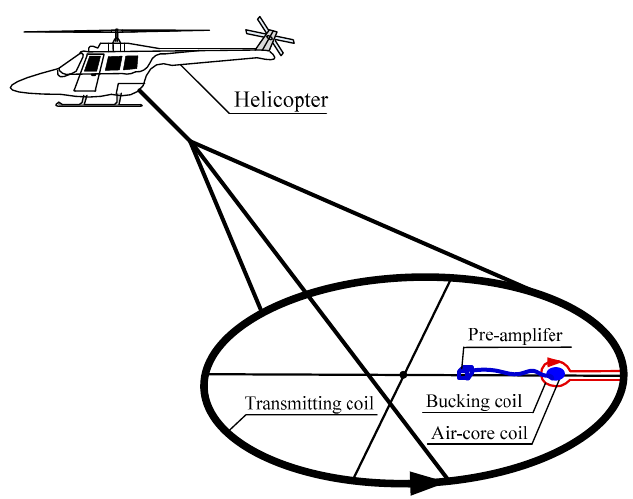
Figure 1. Helicopter transient electromagnetic (TEM) system configuration.